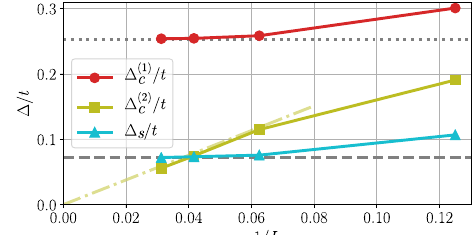
FIG. 4. Gaps for U=t ¼ 10 at hole doping p ¼ 1 = 16 on L × 4 cylinders for different cylinder lengths L from DMRG using Eqs. (10), (12), and (13). We find that for large cylinder lengths, the single-particle gap Δ c and the spin gap Δ s approach finite 1 Þ =t ≈ 0 . 25 and Δ =t ≈ 0 . 07 . The charge gap Δ ð 2 Þ values Δ ð c c s vanishes ∝ 1 =L despite being of order 0.1 on the finite-size lattices. The dashed and dotted lines are a guide to the eye.